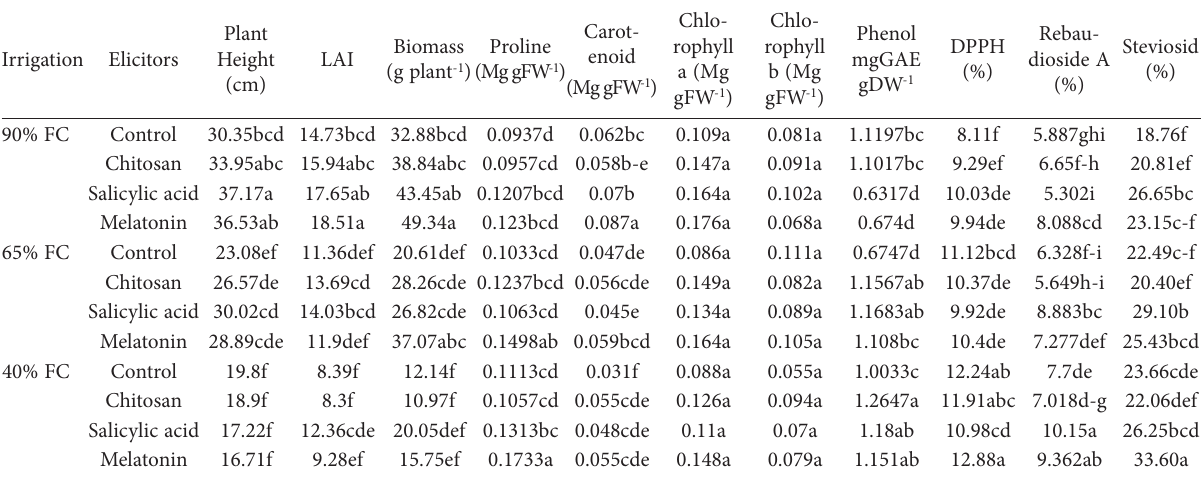
Table 4. Mean comparison of irrigation and spraying elicitors interaction treatments of on studied traits in Stevia ( Stevia rebaudiana Ber- toni